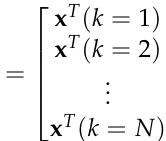
V O ≈ 0 2 , sec V O 2 , prim V O ≈ 0.35 2 , sec V O 2 , prim V O ≈ 0.57 2 , sec V O 2 , prim V O ≈ 2 , sec V O 2 , prim